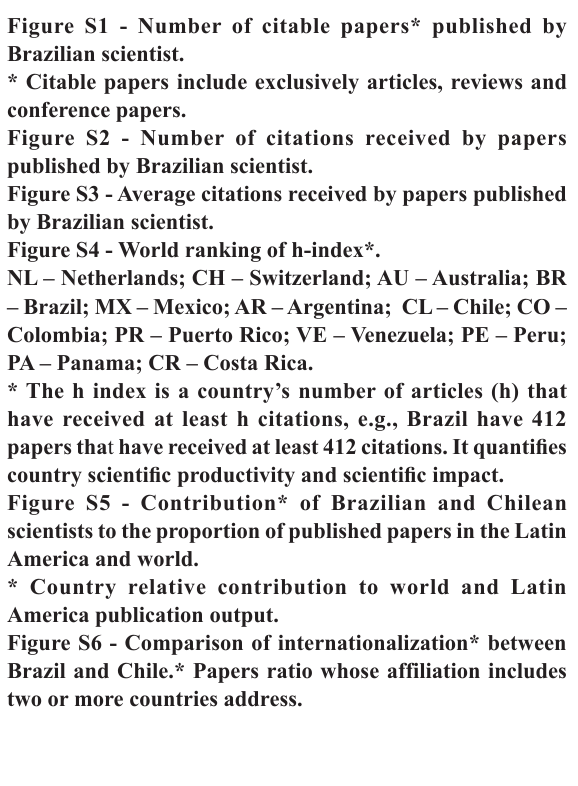
Figure S6 - Comparison of internationalization* between Brazil and Chile.* Papers ratio whose affiliation includes two or more countries